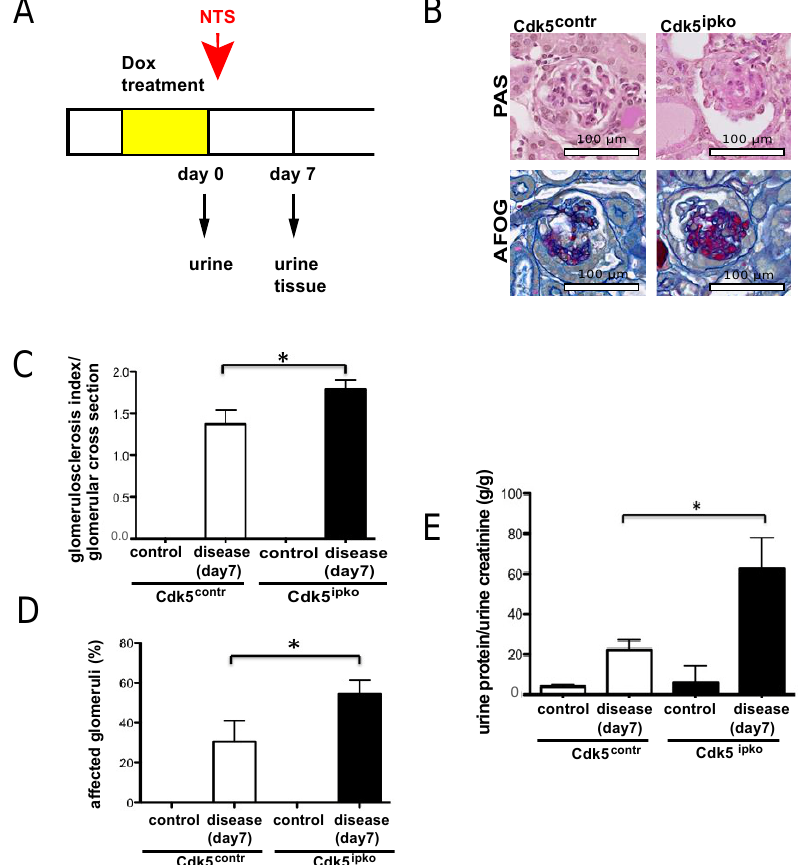
Figure 4. Nephrotoxic nephritis model in inducible podocyte-specific Cdk5 knockout mice. ( A ) Timing scheme of the NTN study including doxycycline treatment, nephrotoxic serum (NTS) application, urine sampling, and histologic analysis. ( B ) PAS- and AFOG-staining of Cdk5 contr and Cdk5 ipko kidney sections after NTS application reveals aggravated glomerular damage in Cdk5 ipko . In each cohort, n = 6. ( C ) Quantification of glomerular sclerosis according to grades of percentage of the glomerular tuft area involved. The average glomerular fibrosis index per glomerular cross section was 1.79 (SD 0.10) for Cdk5 ipko , as compared to 1.37 (SD 0.16) in Cdk5 contr after NTS application (* p < 0.05). No glomerular damage was detected in Cdk5 ipko and Cdk5 contr treated with saline instead of NTS. In each cohort, n = 6. ( D ) Extent of glomerular in- volvement quantified as percentage of glomeruli with sclerosis. Cdk5 ipko mice showed involvement of 56% (SD 5) of the glomeruli, whereas Cdk5 contr showed involvement of 30% (SD 7). In each cohort, n = 6; * p < 0.05. ( E ) Protein/creatinine ratio ( g/g ) of Cdk5 ipko compared to Cdk5 contr shows aggravated proteinuria of 62.46 (SD 15.35) g/g creatinine in Cdk5 ipko vs. 22.11 (SD 5.10) in Cdk5 contr (* p < 0.05). No significant proteinuria was detected in mice treated with saline instead of NTS. In each cohort, n = 6.